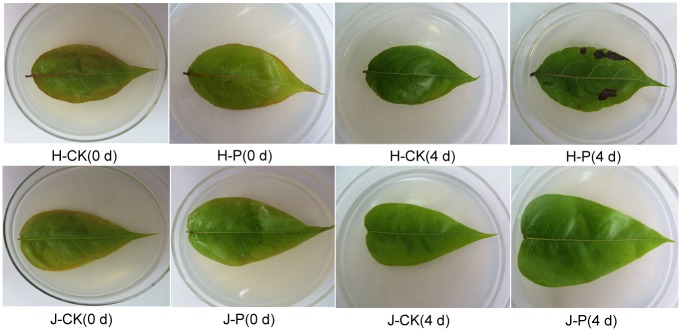
Disease symptoms in ‘Hongfen’ and ‘Jinjing’ pear after PBS inoculation.The leaves of ‘Hongfen’ pear inoculated with strain H presented a small brown necrosis at the early disease stage and large necrotic lesions on day 4, and the leaves of ‘Jinjing’ pear inoculated with strain H showed negligible necrotic spots.